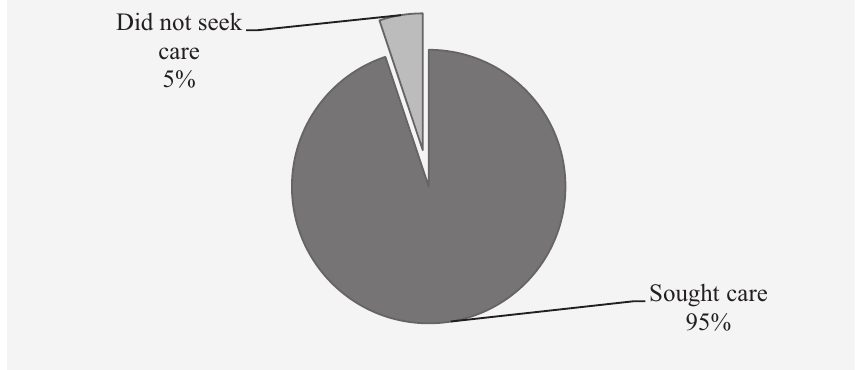
Figure 4. Percentage of